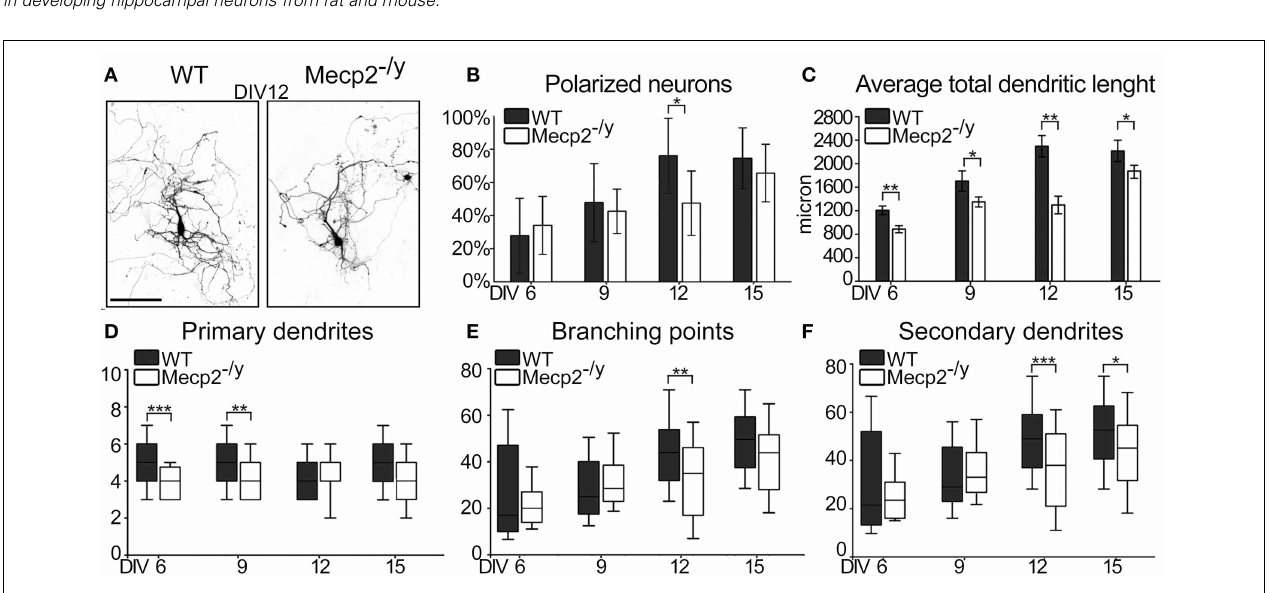
total dendritic length. Data are expressed as mean ± s.e.m., n = 40. Quantification of primary dendrites (D) , branching points (E) and of the secondary dendrites ( F ) at DIV6, 9, 12, and 15. The median line of the boxes refers to the 50 percentile of the entire population. Mann-Whitney Rank